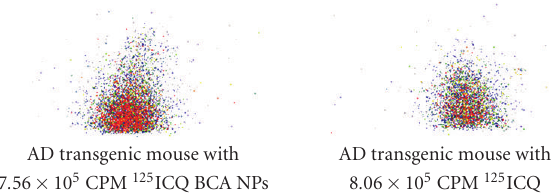
Table 3: 7 month AD transgenic with 9 month control with 125